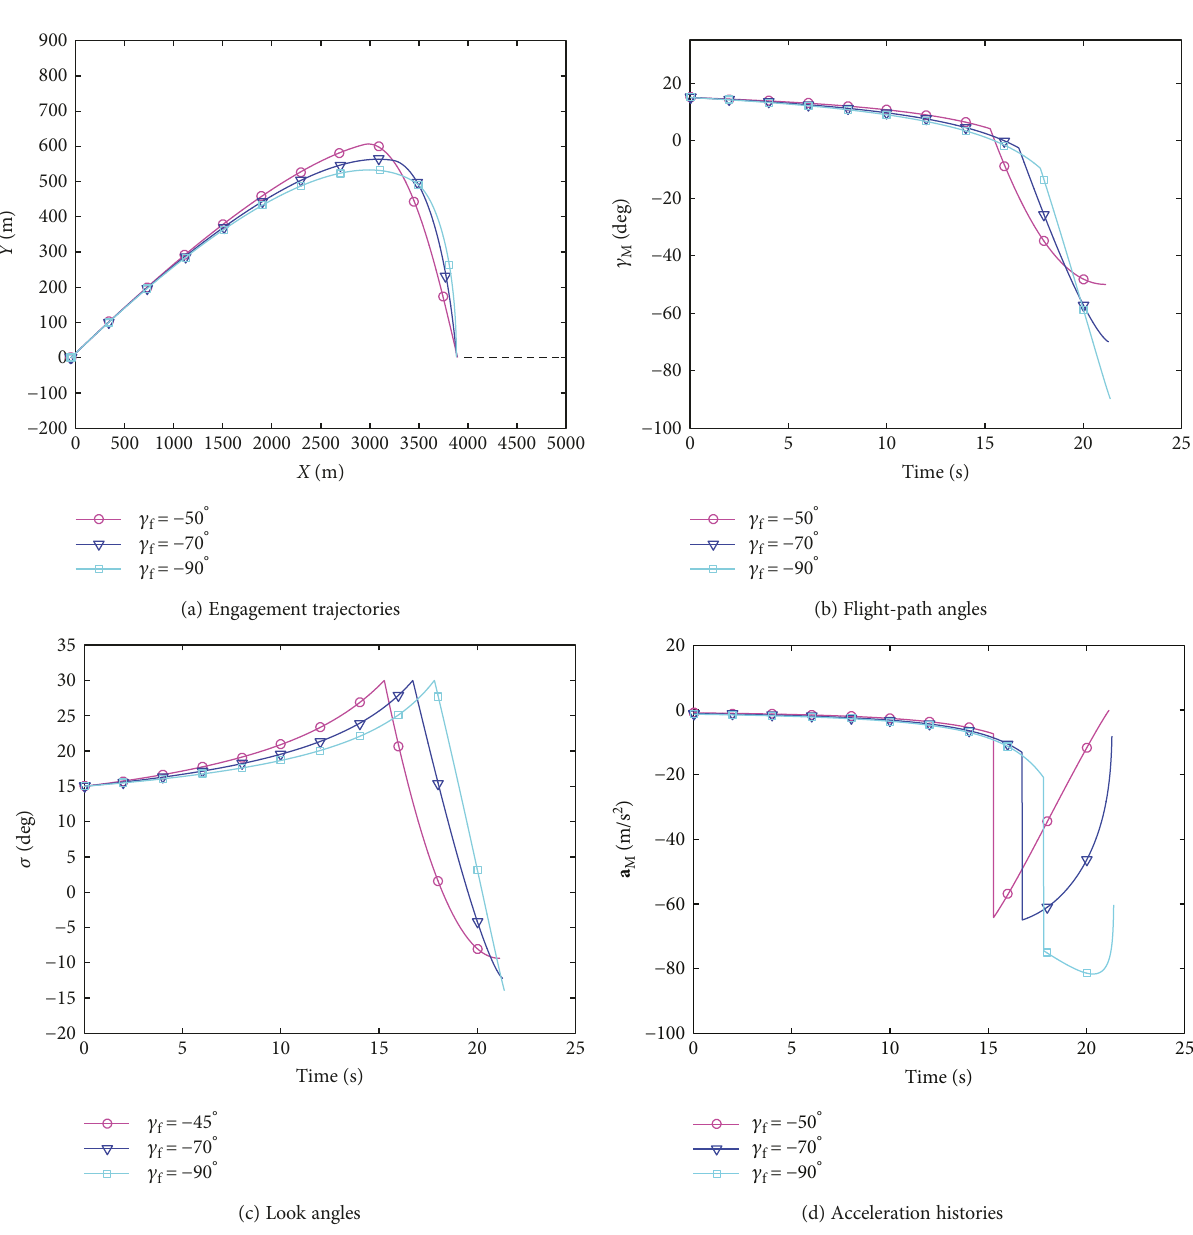
Figure 5: The results for the di ff erent terminal impact